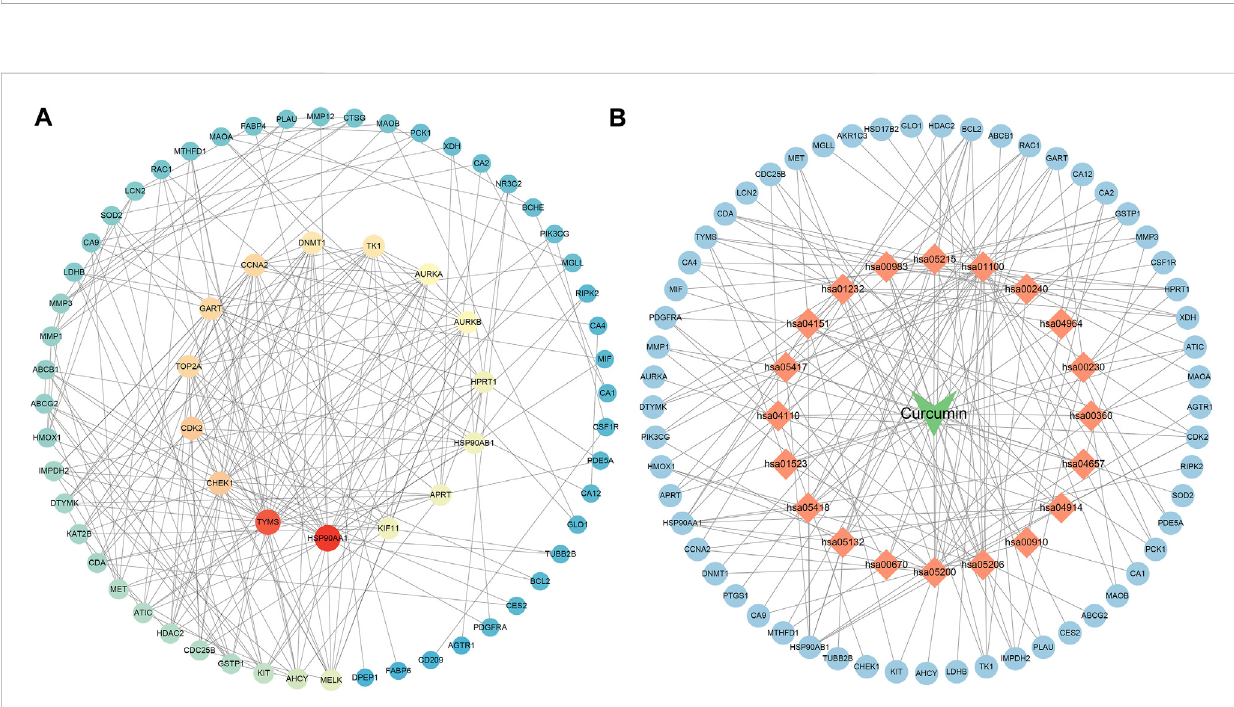
FIGURE 3 PPI network diagram ( (A) . PPI network of potential targets for curcumin therapy of colon cancer. (B) . Drug-target-pathway network diagram. The blue circles represent targets, the orange diamonds are pathways, and the green triangles are